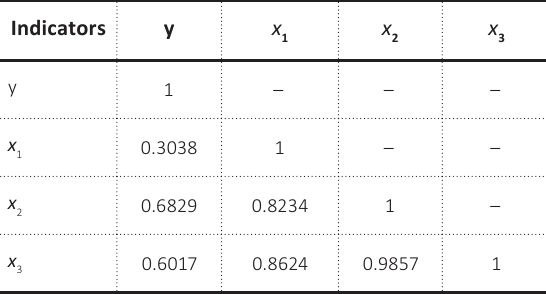
Table 3. Correlation matrix